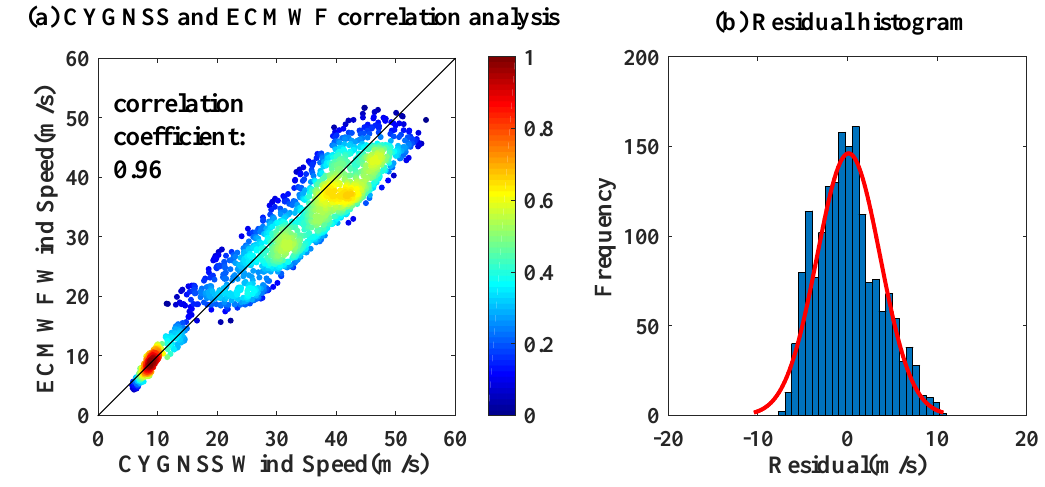
Figure 3. Scatter density plot and residual distribution of CYGNSS and ECMWF wind speeds. ( a ) Scatter plot of CYGNSS and European Centre for Medium-Range Weather Forecasts (ECMWF) wind; ( b ) CYGNSS and ECMWF wind-speed residual distribution